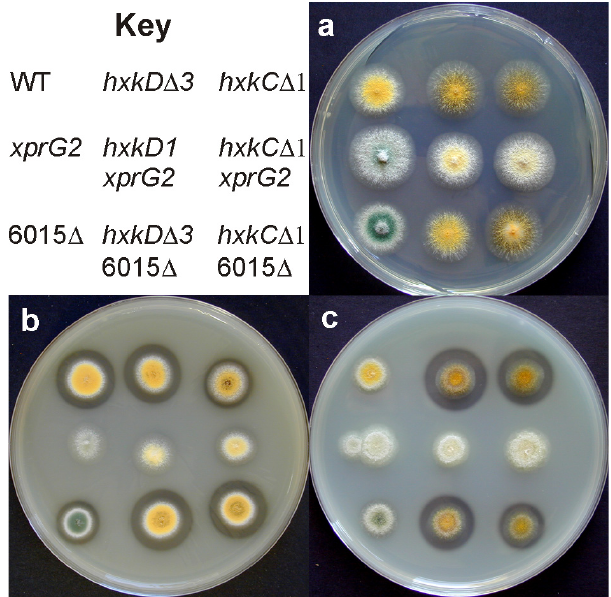
Figure 8. Phenotype of the AN6015 D gene disruption mutant. Colony morphology and extracellular protease production of wild-type and mutant strains on ( A ) minimal medium ( B ) medium containing milk as a nitrogen source and ( C ) medium containing milk as a carbon source. The clear halo surrounding colonies on medium containing milk is due to extracellular protease activity. The full genotypes of strains MH97 (WT), MK198 ( xprG2 ), MK481 (6015 D ), MK320 ( hxkD D 3 ), MK186 ( hxkD1 xprG2 ), MK532 ( hxkD D 3 6015 D ), MK388 ( hxkC D 1 ), MK408 ( hxkC D 1 xprG2 ), and MK531 ( hxkC D 6015 D ) are given in Table